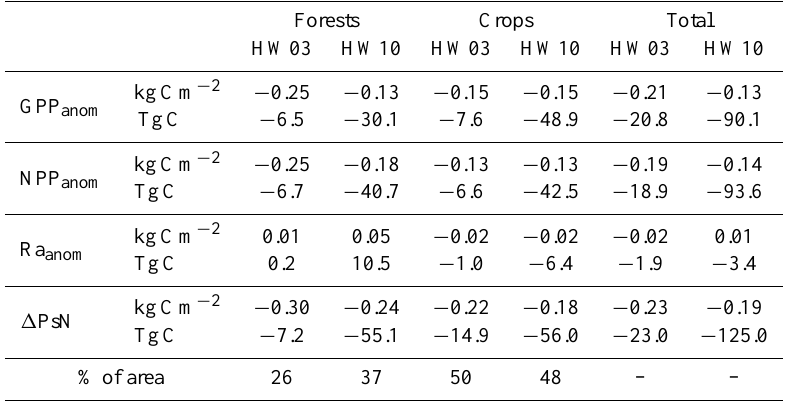
Table 1. Relative and total GPP anom , NPP anom , Ra anom and difference in accumulated PsN during 2003 (HW03) and 2010 (HW10) for each region. Values for forests, crops and total area are given in each column. Results are presented as average carbon uptake (in kgCm − 2 ) and the corresponding integrated balance over each region (in TgC). Forests Crops Total HW03 HW10 HW03 HW10 HW03 HW10 kgCm − 2 − 0.25 − GPP anom